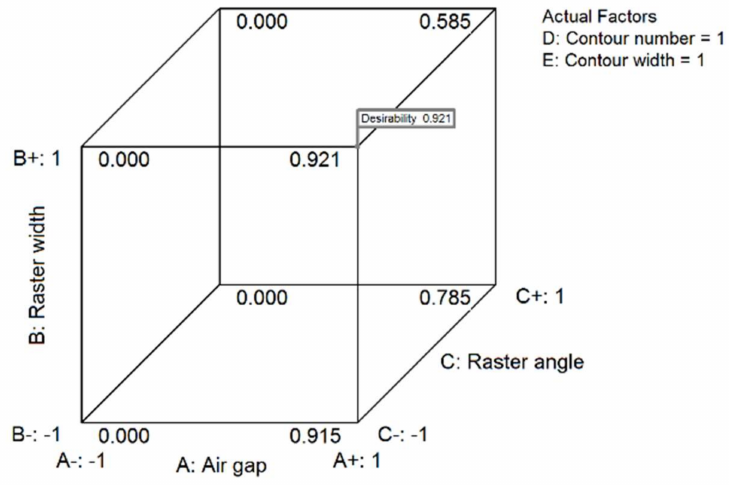
Figure 21. Cube desirability showing values at different parameter